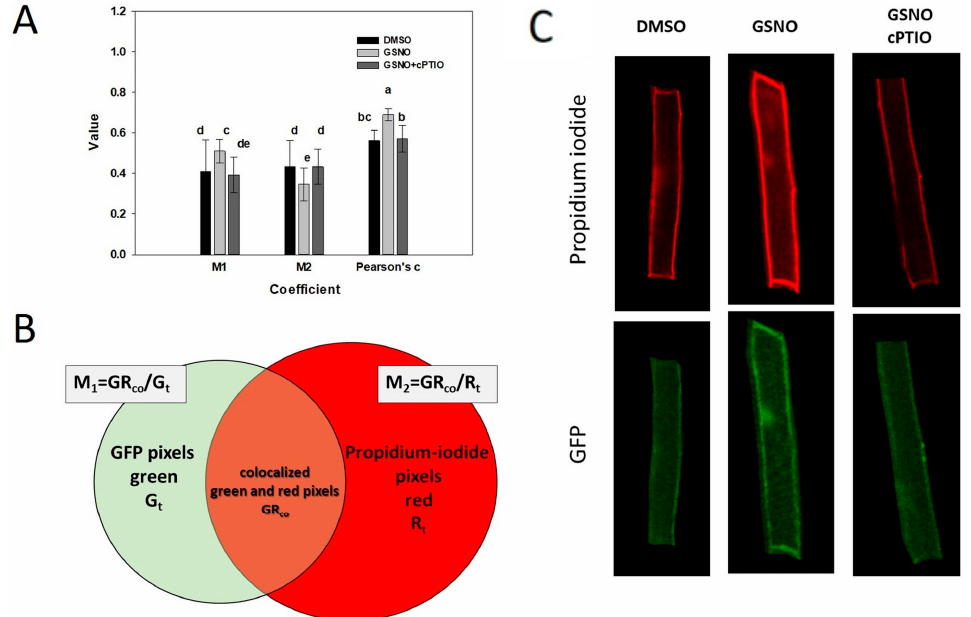
Figure 4. Effect of GSNO treatment on the intracellular localization of GFP:ROP2 expressed under the control of its own promoter in root cells. ( A ) Average values of Manders’ colocalization coefficients (M1 and M2) and Pearson’s coefficient. Seven-day-old Arabidopsis seedlings were treated 4 h in dark as indicated (DMSO as solvent control, 250 µM GSNO as NO donor, 800 µM cPTIO as NO scavenger) and further cultured for 20 h before fluorescent microscopy. Cell periphery was stained by propidium iodide (PI). Individual cell images in silico separated from whole stained root pictures with the aim of the ImageJ plugin JaCoP were used for localization studies [49]. Mander’s colocalization coefficients (M1, M2) and Pearson’s coefficient were calculated for 22-22 cells according to [50]. Statistical analysis was analysis of variance followed by Duncan’s test. Different letters mean significant difference at the p < 0.05 level. M1—ROP2 fraction at the cells’ periphery out of total ROP2 expressed; M2—the fraction of cell periphery that has ROP2; Pearson’s c—the overall correlation of green and red pixels in the cells. ( B ) The calculation of M1 and M2 coefficients. Gt—total amount of green pixels generated by the expression of GFP-tagged ROP2 in the region of interest (ROI) studied. Rt—total amount of red pixels in a ROI, generated by propidium–iodide molecules labelling the cell’s periphery. PI labels only whole cells with undamaged, intact membranes and only those cells were chosen as ROI. GRco—indicate green pixels colocalized with red pixels. ( C ) Example individual cell images used to calculate the coefficients shown in part A. Individual cell images were separated as ROI from whole stained roots using the ImageJ plugin, JaCoP